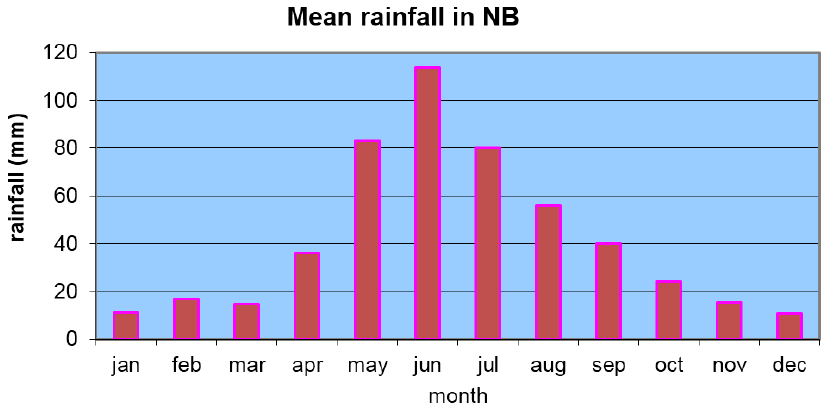
Figure 3. Spectral analysis of the six-month standardized precipitation index in the Neuquén River basin. SP is the spectral density and F is the frequency (year −1 ).